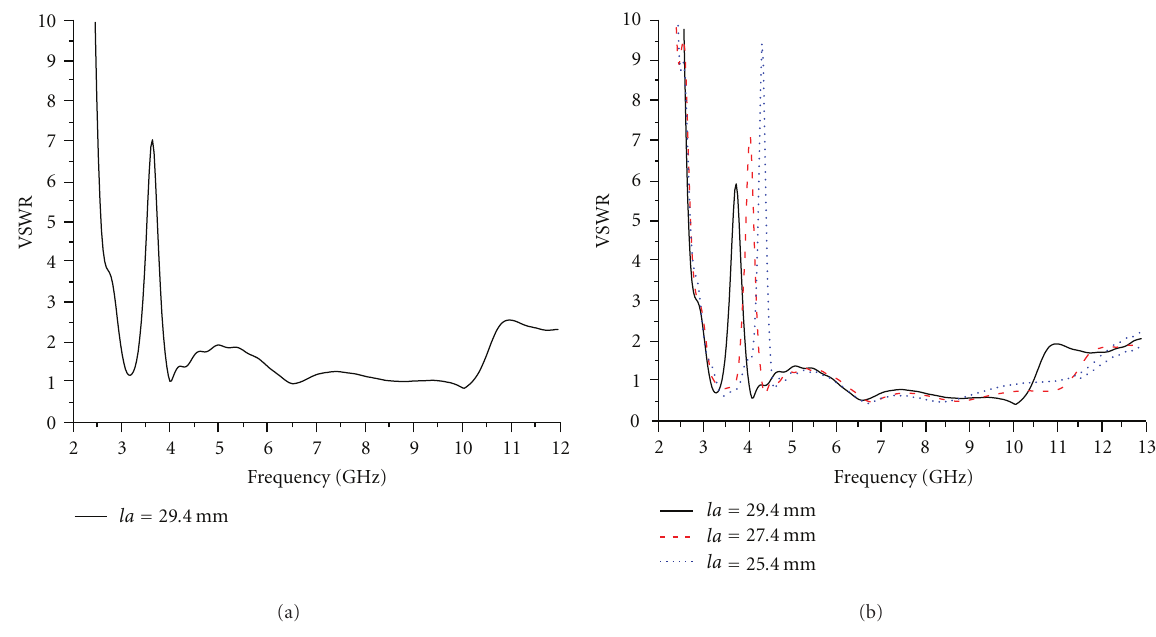
Figure 2: Simulated VSWR of single band-notched antenna with (a) optimized la , (b) di ff erent la